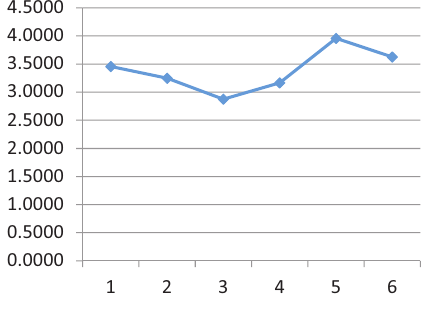
Table 1. Residents’ reason for living a comfortable